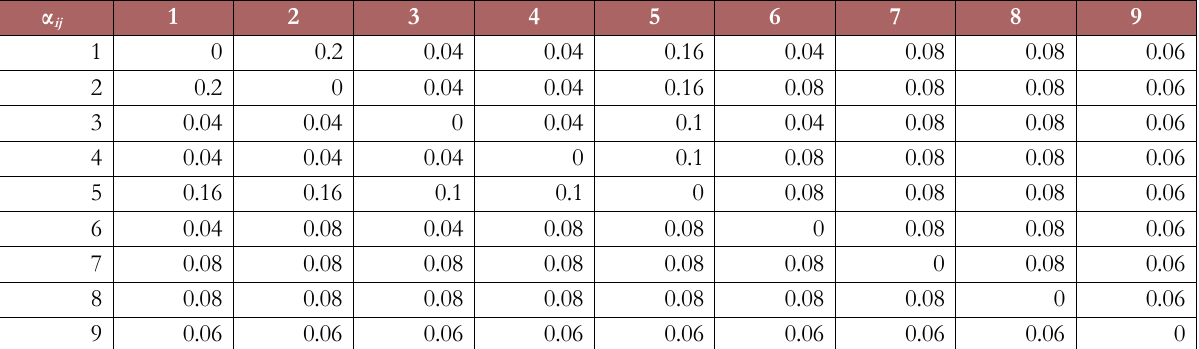
Table 2. The duty rate between countries